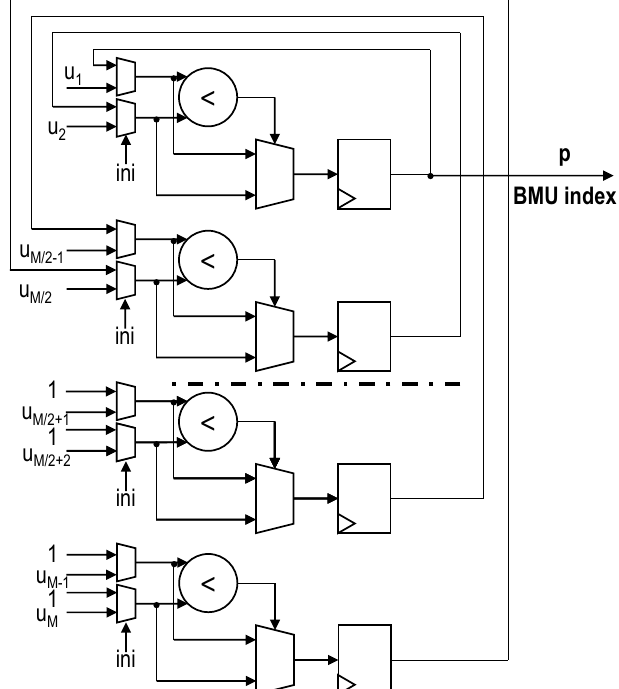
Figure 15. Scheme of the proposed recursive tree comparer architecture that substitutes a traditional comparer